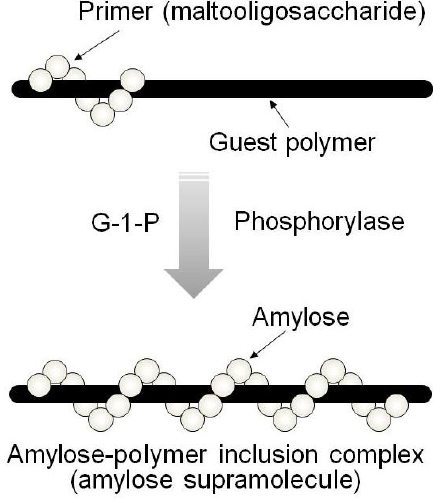
Figure 4. Image of “vine-twining polymerization”.